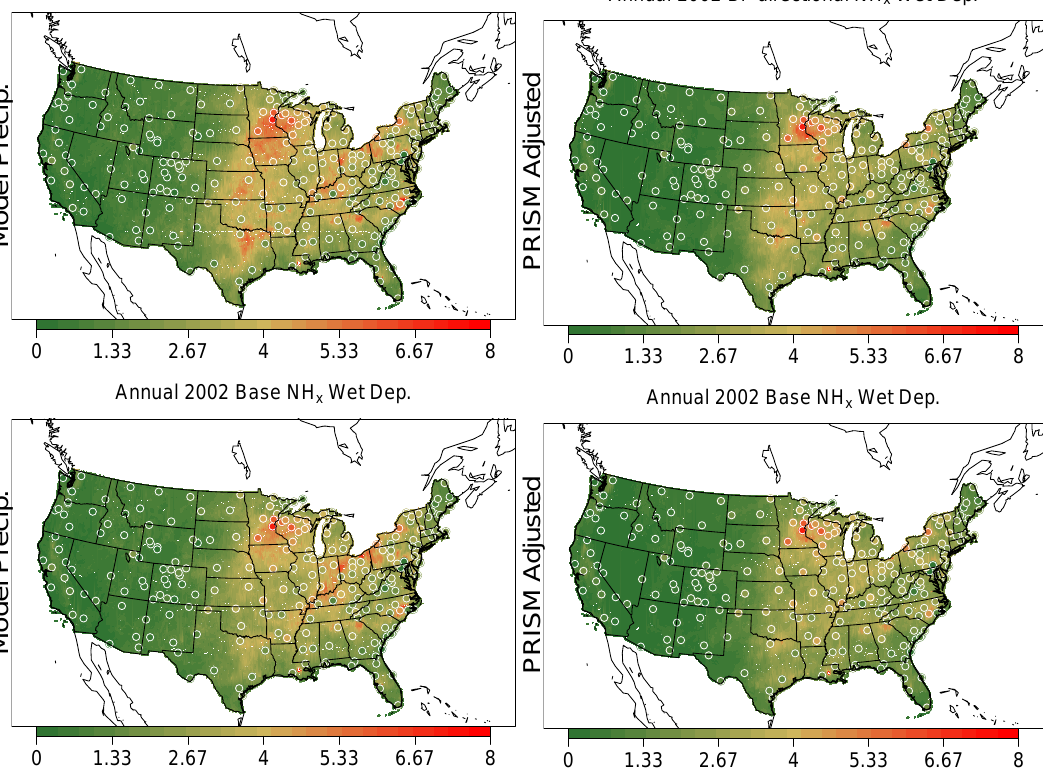
Fig. 2. Maps of bidirectional and base annual NH x wet deposition fields, top two panels respectively, annual NH x deposition maps scaled by annual 2002 PRISM precipitation fields for bidirectional and base cases, bottom two panels respectively. Mean annual NADP observations at each measurement site ( N = 243) are plotted in the same color scales over the modeled